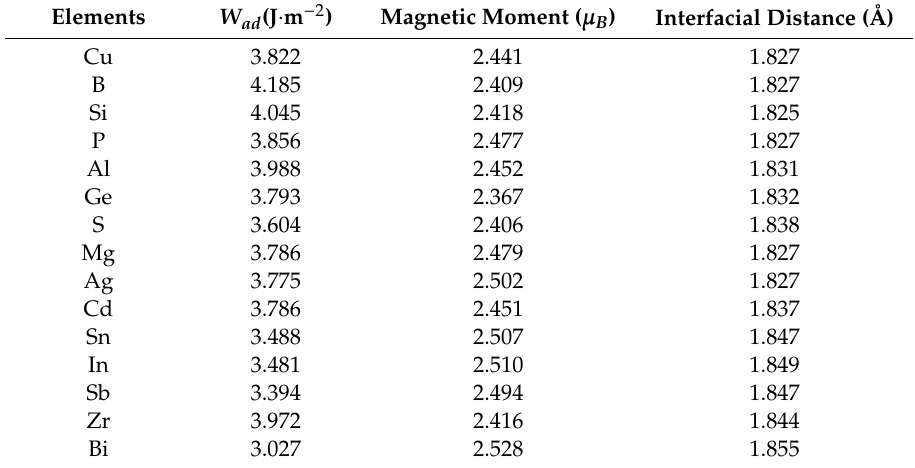
Table 5. E ff ects of alloying elements on the work of adhesion, the magnetic moment and the interfacial distance of fully relaxed